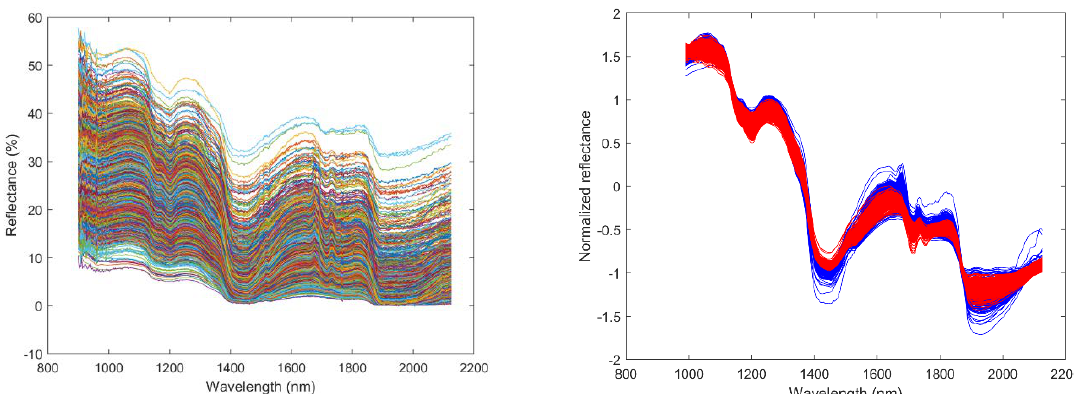
Figure 4. Raw spectra of olives ( left ) and standard normal variate spectra ( right ) in the seasons 2016 (red color) and 2017 (blue color).